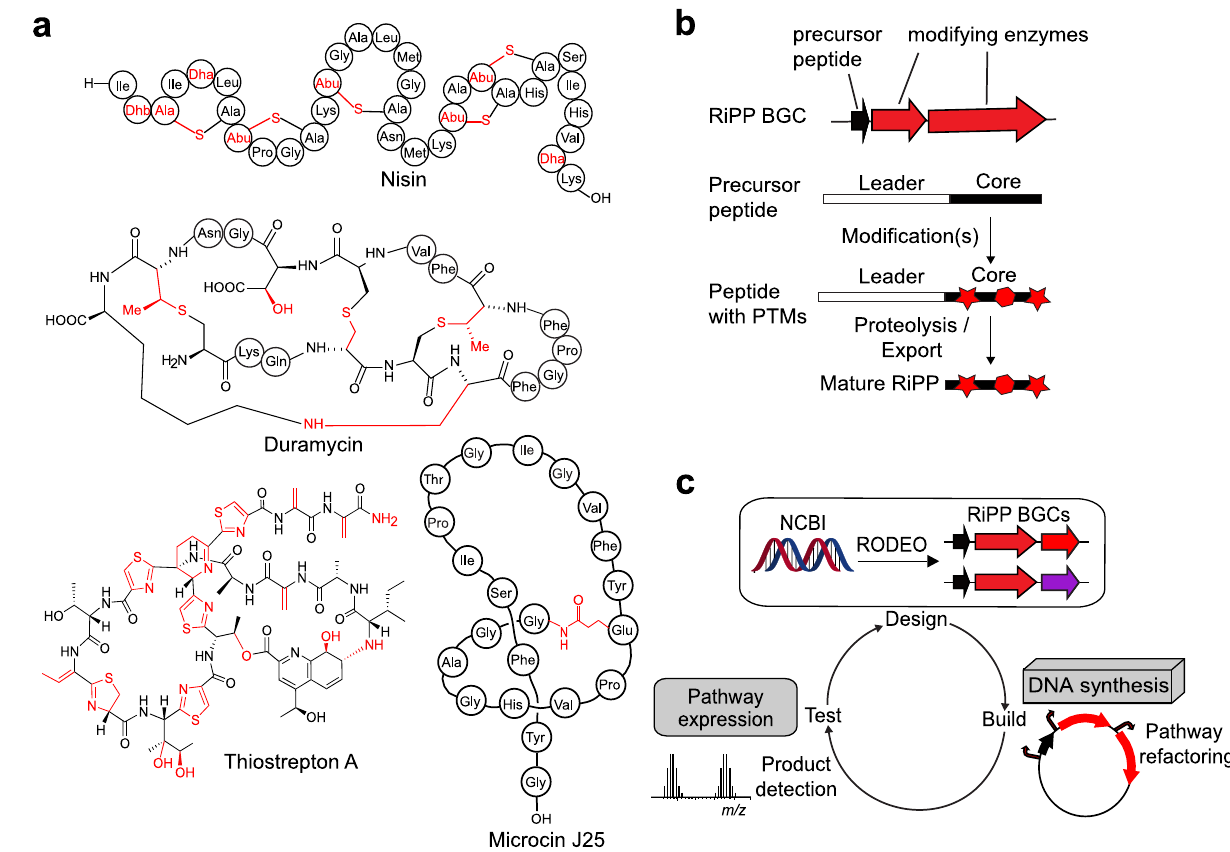
Fig. 1 | Overview of RiPPs and FAST-RiPPs pipeline. a Examples of RiPPs with biological activities relevant to human society. Nisin is used commercially in the food industry to combat food-borne pathogens 38 , duramycin is used in diagnostics 76 , thiostrepton is used in veterinary medicine 77 , and microcin J25 is a